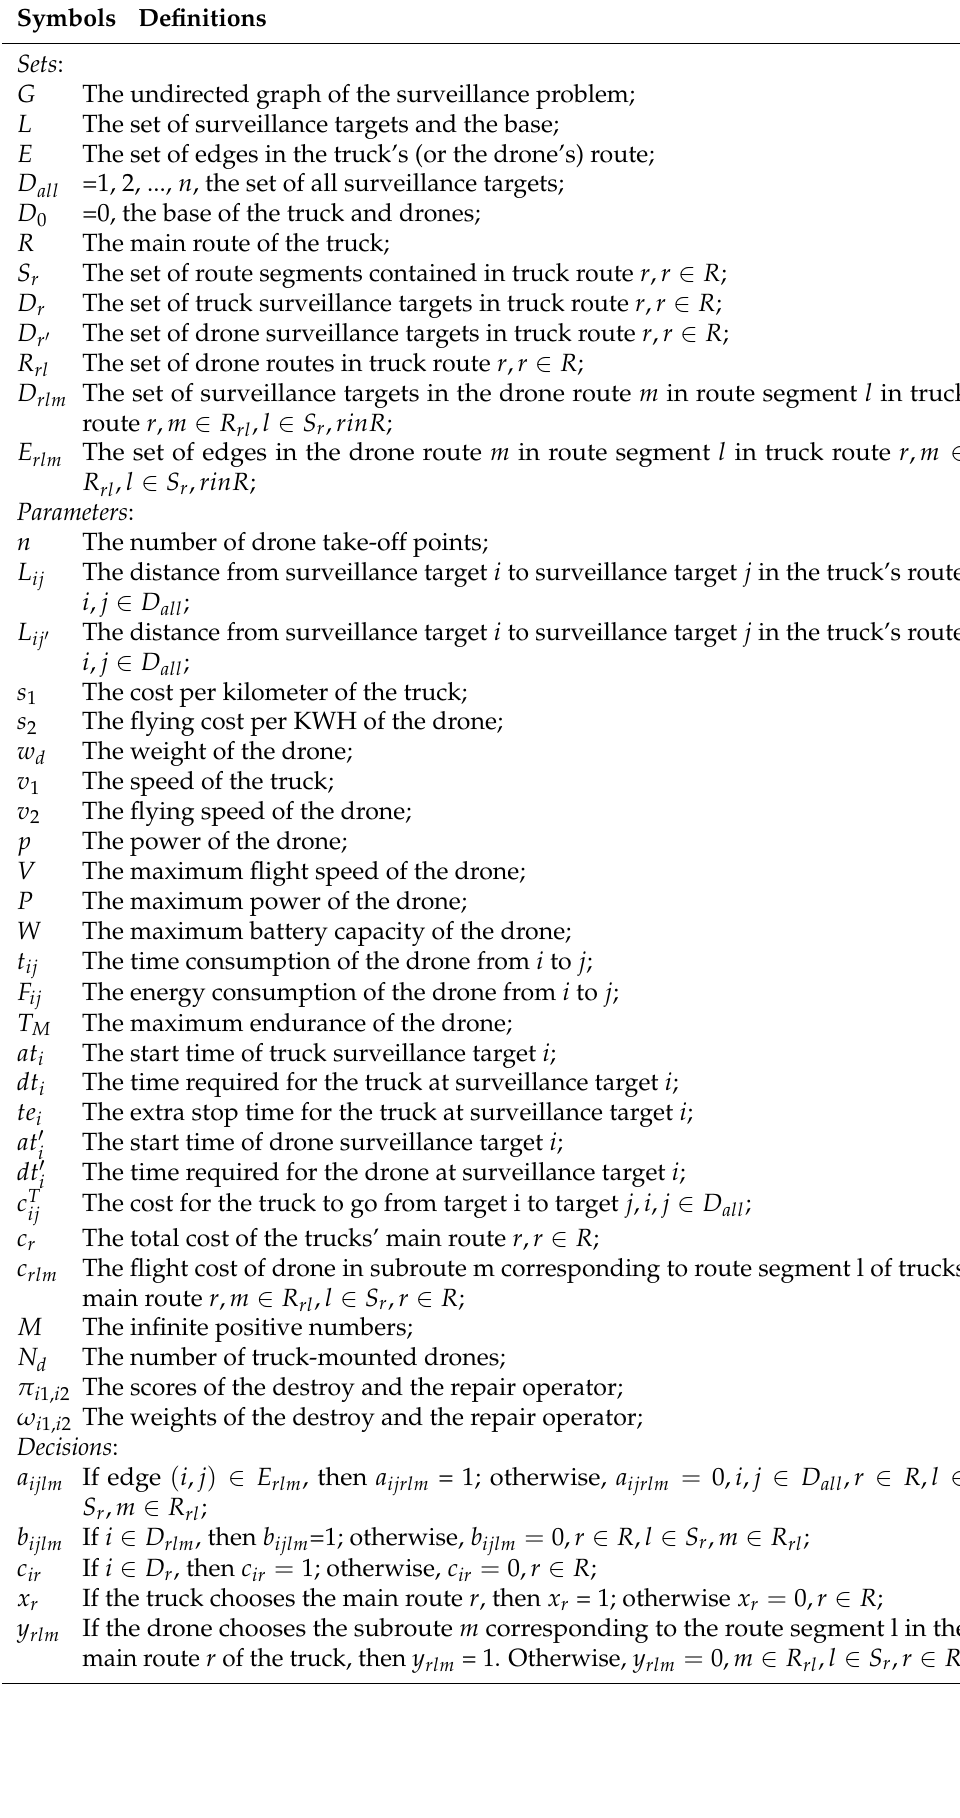
Table 1. Symbols and